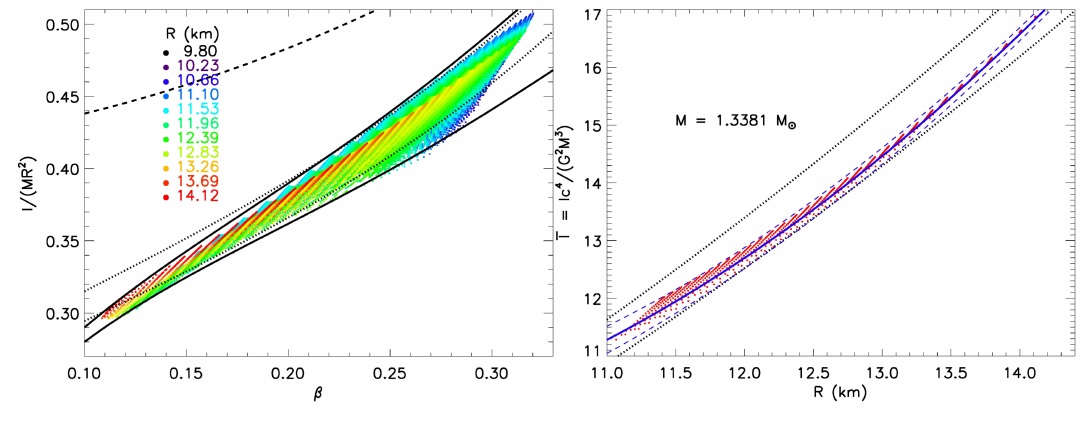
Figure 5. Moments of inertia computed from piecewise polytropes. Left : Points show values of I / ( MR 2 ) as a function of compactness β assuming M max ≥ 2.01 M (cid:12) and 8.4 MeV fm − 3 < p 1 < 30 MeV fm − 3 . The solid curves show bounds from Equation (16). The dashed curve is the causal upper limit [37], and colors indicate radius values. Right : The dimensionless moment of inertia ¯ I = Ic 4 / ( G 2 M 3 ) as a function of radius R for M = 1.3381 M (cid:12) . The dashed curves show the bounds from Equation (17) and the dotted curves show the bounds from Equation (16).